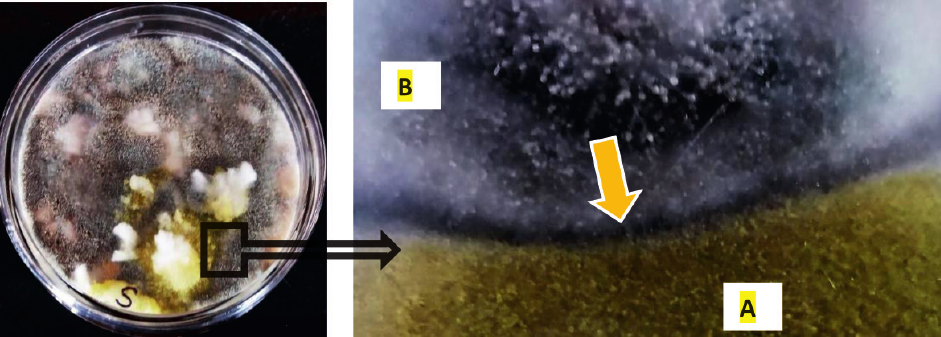
Fig. 2. Mycelial interaction between the pathogenic A. flavus (A) and A. giganteus (B) showed no intermingling of hyphae in the region between the two hyphae at the periphery as indicated (enlarged